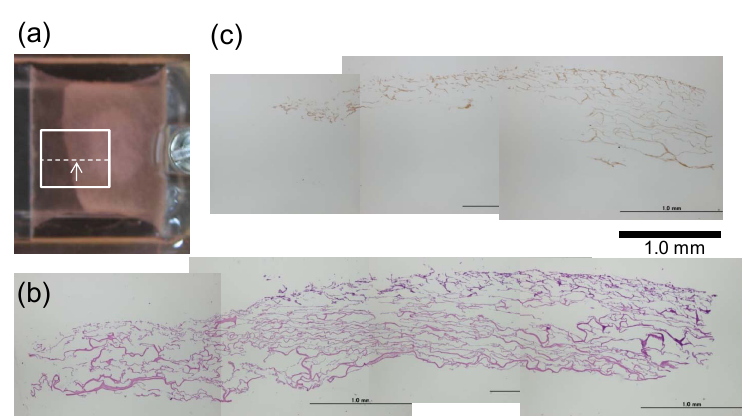
Figure 5 Microscopic observation of a cross-sectioned construct. (a) Top view of a construct showing the observation site that included a calcified region. The part of the construct surrounded by a white rectangle was cross-sectioned along the dash line. (b) The cross-section was stained by the HE method, which stains the fiber network of the porous collagen scaffold. (c) The corresponding plane stained by the von Kossa method, which indicates calcification of the matrix.